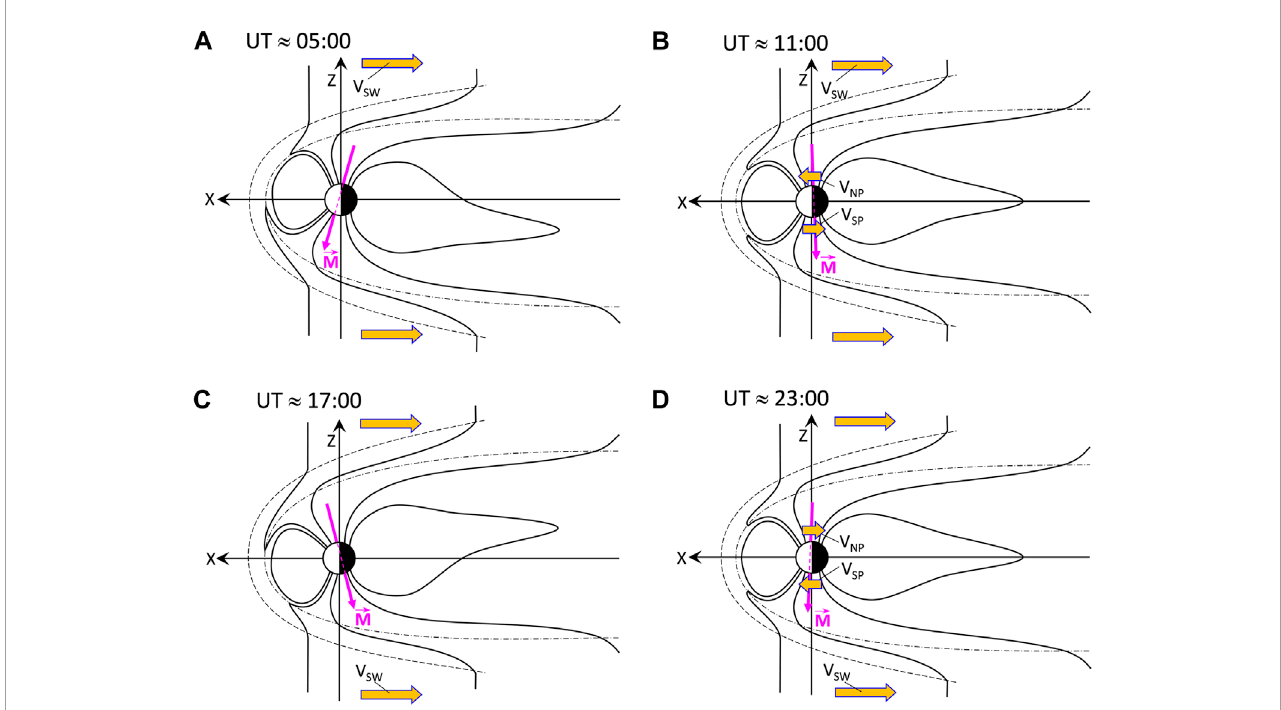
FIGURE 2 Schematics of pole motions in a geocentric-solar frame (i.e., one fixed with respect to both the Earth and the Sun). The panels show the magnetosphere in the noon-midnight (XZ) plane at (A) near 05 h UT ; (B) near 11 h UT ; (C) near 17 h UT ; and (D) near 23 h UT at equinox. The mauve arrow shows Earth’s magnetic axis ⃗ M . Note that, by convention, the north/south pole of a magnet is where field lines diverge/converge and so for the current polarity of the geomagnetic field, the magnetic pole in the southern hemisphere is, by that convention, a north magnetic pole and vice versa : in this paper, we refer to a magnetic pole by the hemisphere of the Earth that it is in and not by the magnet convention. The mauve arrow shows the magnetic moment of an eccentric dipole. The dot-dashed lines are the magnetopause and the dashed lines the bow shock. Outside the bow shock the solar wind flows in the − X direction at speed V SW . At around 05 h UT the “north” magnetic pole (i.e., the magnetic pole in the northern hemisphere) is pointed away from the Sun and the “south” magnetic field is pointed toward it. At around 17 h UT the north/south magnetic pole is pointed toward/away from the Sun. At around 11 h UT the north/south magnetic pole is moving toward/away from the Sun and at around 23 h UT the north/south magnetic pole is moving away from/toward the Sun. The sunward component of the motion of the north/south magnetic pole at ionospheric F-region altitudes in any geocentric-solar frame is V NP and V SP ,